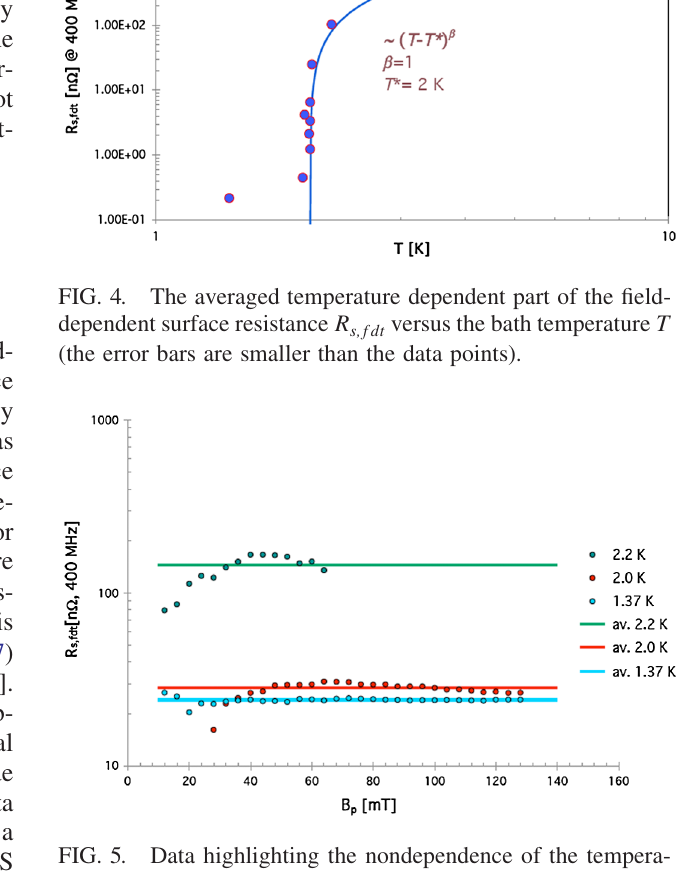
FIG. 5. Data highlighting the nondependence of the tempera- ture dependent part of R s;fd on the magnetic field B ; the individual data were taken at three different bath temperatures for one